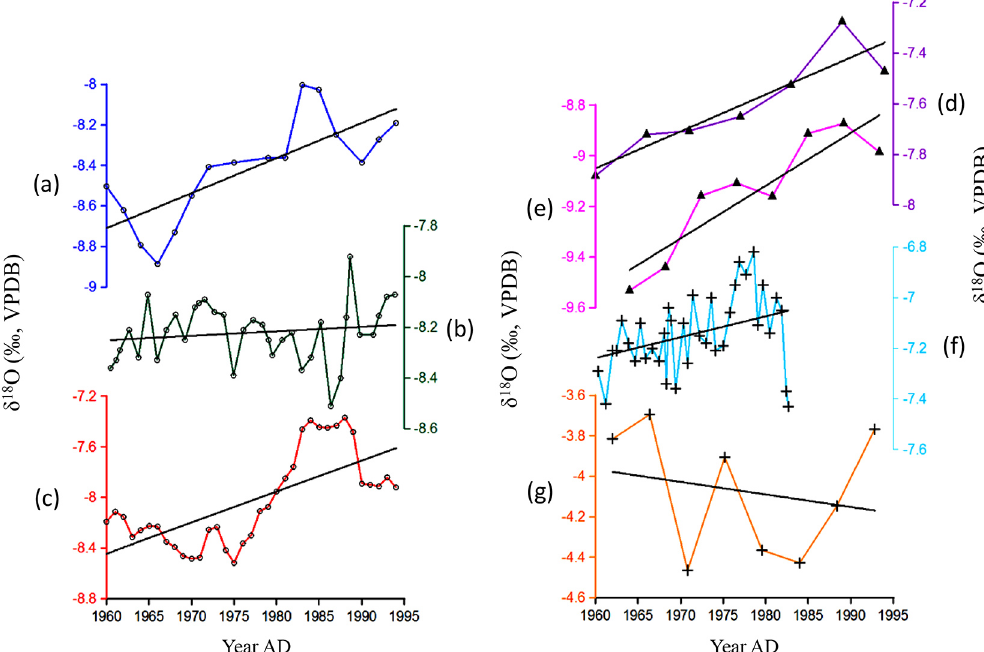
Figure 1. The trend estimation in the time series of the δ 18 O cs (1960–1994). Here, (a) is S312 from Shihua Cave, (b) is WX42B from Wanxiang Cave, (c) is HS4 from Heshang Cave, (d) is D15 from Dongge Cave, (e) is HY3 from Huangye Cave, (f) is DY1 from Dayu Cave, and (g) is A1 from Lianhua Cave (see text for details).